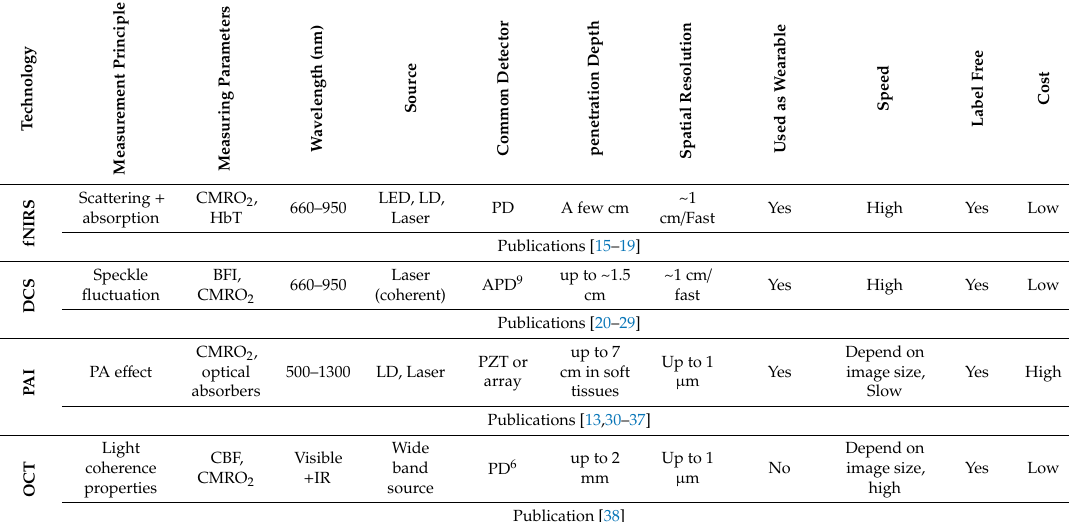
Table 1. Comparison between most common optical techniques that are non-invasive, label-free and can provide information on brain